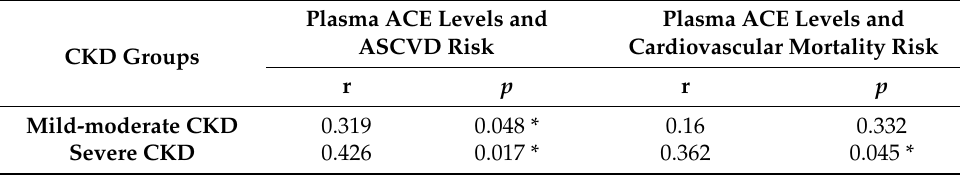
Table 4. Results of the correlational analysis between plasma ACE levels with the risk of ASCVD and cardiovascular mortality in each group of